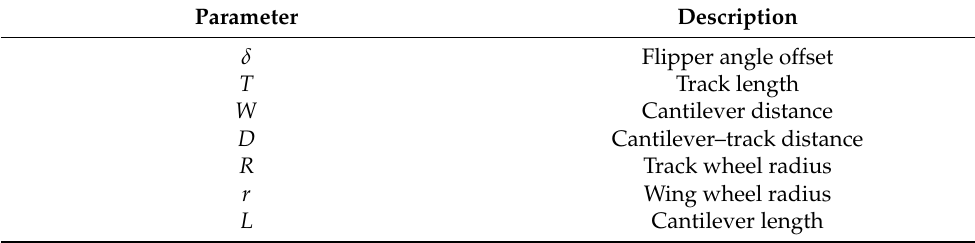
Figure 2. Forward kinematic model of the six-track robot. Table 1. Nominal parameters of six-track robot.